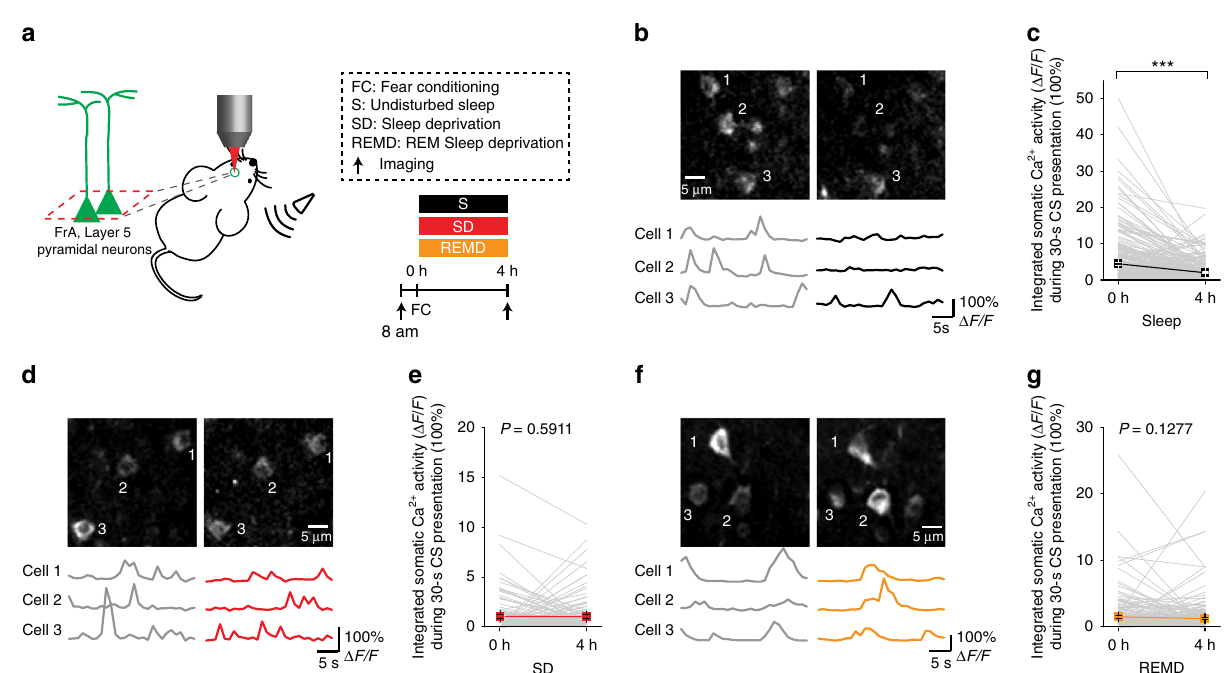
Fig. 4 SD or REMD prevents FC-induced neuronal activity reduction. a Schematic of experimental design. After fear conditioning, mice were either allowed to sleep or subjected to sleep/REM sleep deprivation. Two-photon Ca 2 + imaging was performed to assess the effect of sleep/REM sleep on somatic activity of layer 5 pyramidal neurons in FrA. b Somatic Ca 2 + activity of layer 5 pyramidal neurons in FrA before (left) and after (right) 4-h sleep. Δ F / F 2 + activity over 30 s. Scale bar: 5 μ m. 3 traces: somatic Ca 2 + activities of cells on the top. Ca 2 + fl uorescence 0 was summed to measure somatic Ca traces over 30 s are shown. c The integrated somatic Ca 2 + activity during 30-s CS presentation was signi fi cantly decreased after FC and 4-h undisturbed sleep ( n = 309 cells from 4 mice, P < 0.0001, Wilcoxon signed-rank test, two-sided). d Somatic Ca 2 + activity of layer 5 pyramidal neurons in FrA before (left) and after (right) 4-h SD. e SD for 4 h signi fi cantly prevented the reduction of neuronal activity ( n = 122 cells from 5 mice, P = 0.5911, Wilcoxon signed-rank test, two-sided). f Somatic activity of layer 5 pyramidal neurons in FrA before (left) and after (right) 4 h of REMD. g REMD over 4 h signi fi cantly prevented the reduction of neuronal activity ( n = 195 cells from 3 mice, P = 0.1277, Wilcoxon signed-rank test, two-sided). *** P < 0.001. Data are presented as mean ± s.e.m. Source data for ( c ), ( e ), and ( g ) are provided as a Source Data fi